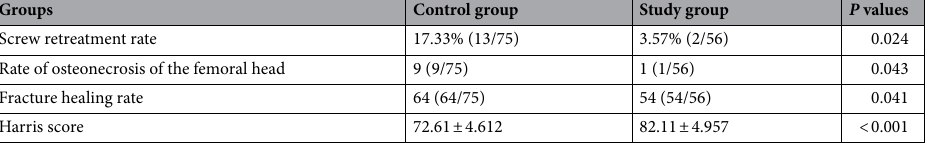
Table 3. Comparison of two groups Follow-up results ( x ± s/n). Independent sample t test was performed on the Harris score and the result showing statistical difference. The Fisher’s exact test was conducted for the Screw retreatment rate, rate of osteonecrosis of the femoral head and fracture healing rate, and the results showing statistical difference.